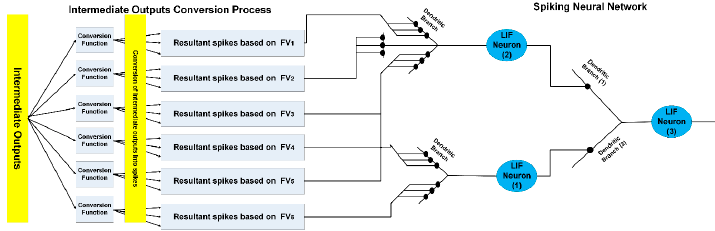
Figure 8. Spiking neural network (SNN) circuit and it dendritic structure that are used as a block to construct the overall SNN. LIF: leaky integrate-and-fire.